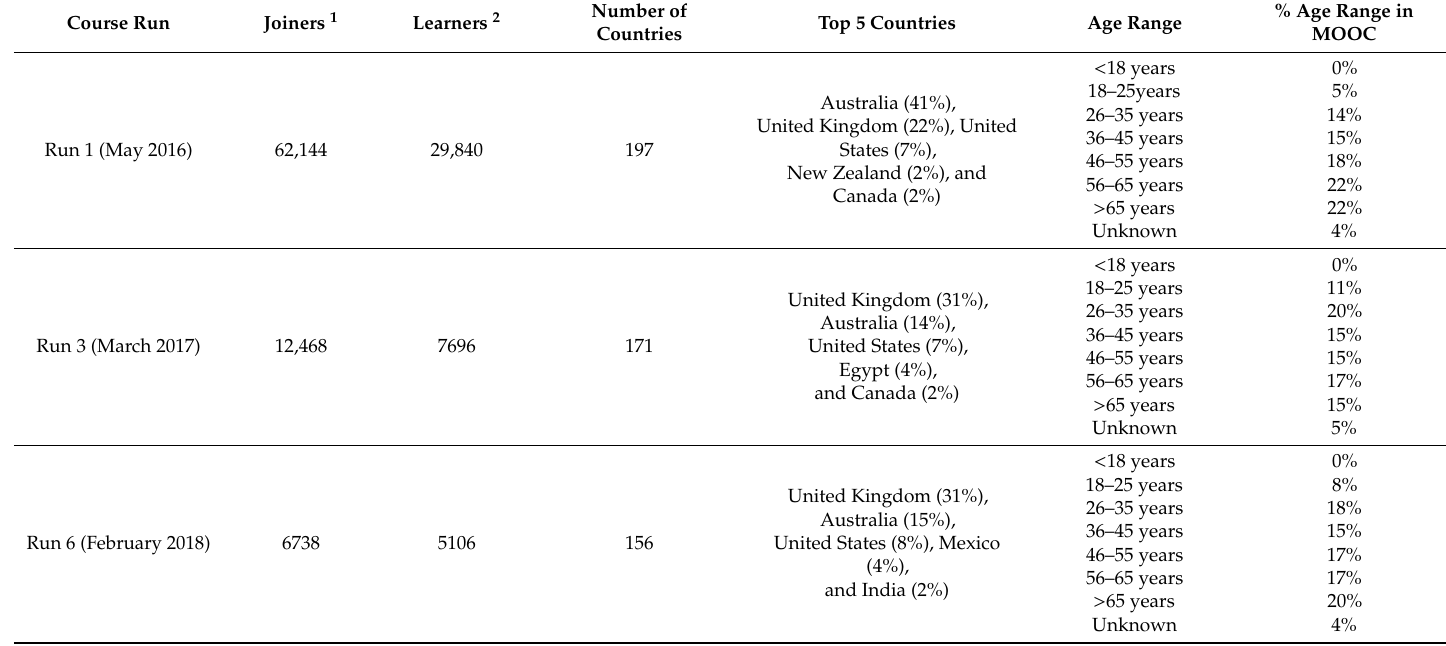
Table A4. Demographics of learners in the Food as Medicine MOOC (data accessed 8 / 2 /